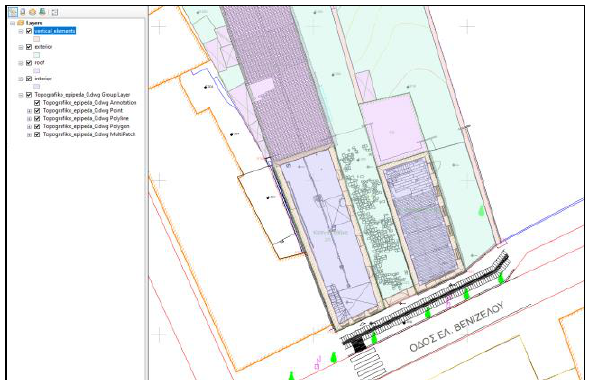
Figure 15 . The GIS application (creation of different feature classes for interiors, exteriors, roofs and vertical